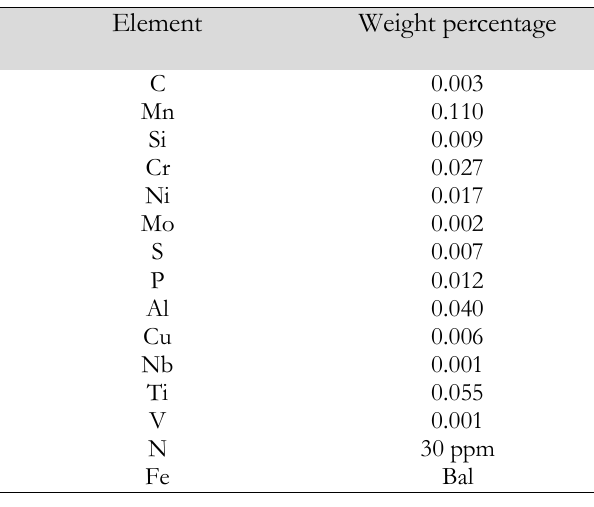
Table 1: Chemical composition of the interstitial free steel used in the